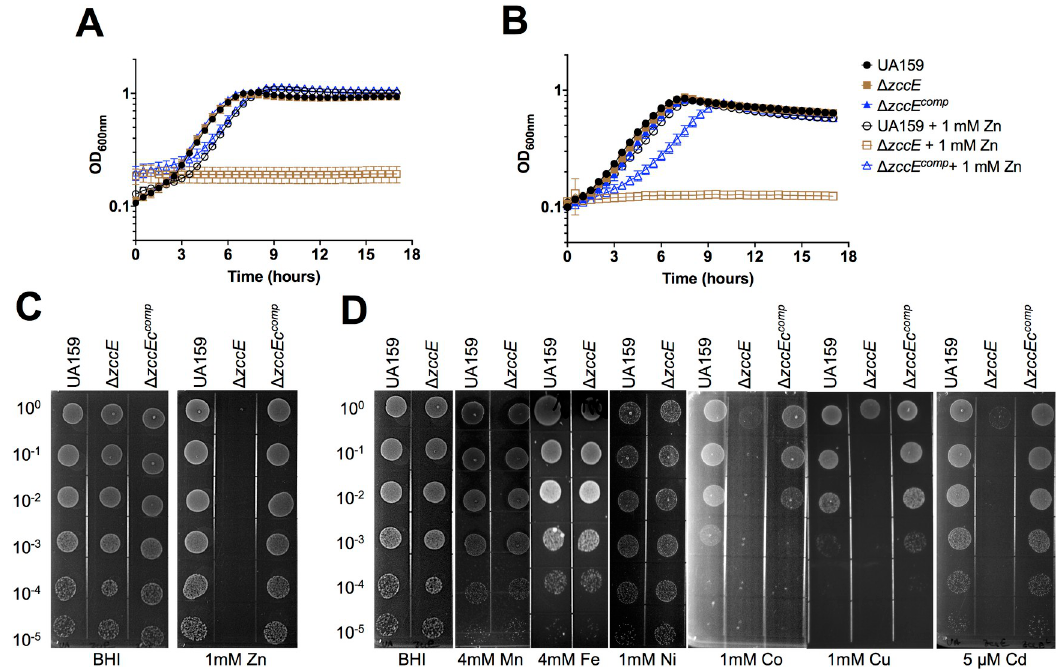
Fig 4. ZccE is a multi-metal exporter responsible for the high Zn tolerance of S . mutans . (A-B) Growth curves of S . mutans UA159, Δ zccE and Δ zccE comp strains in FMC (A) or BHI (B) with or without 1 mM Zn supplementation. Data represent means from 3 independent experiments and the error bars represent standard deviations of the results. A nonlinear curve fit analysis and measuring the doubling time indicated that the growth defect of the Δ zccE strain was statistically significant when compared to either UA159 or Δ zccE comp strains. (C) Plate titration (spot test) of S . mutans UA159, Δ zccE and Δ zccE comp strains on BHI agar with or without 1 mM Zn supplementation. (D) Plate titration of S . mutans UA159 and Δ zccE strains on BHI agar supplemented with